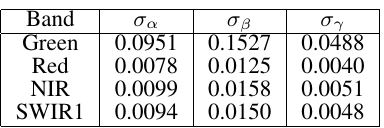
Table 2. The standard deviation of the estimated temporal model parameter values.